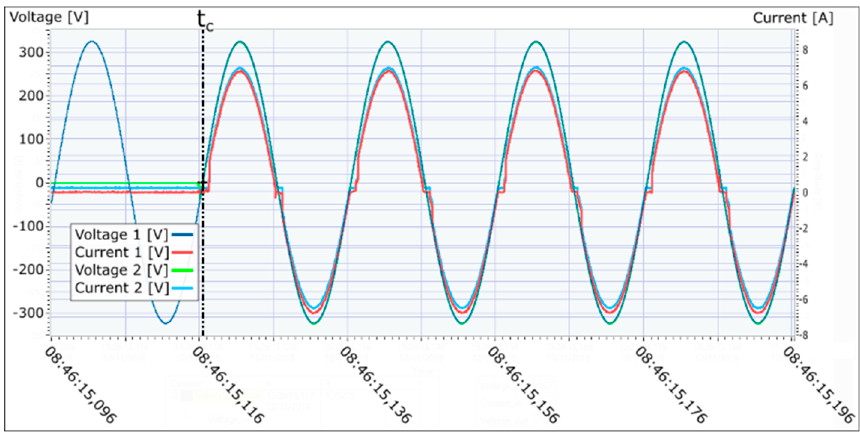
Figure 4. Instant ( t c ) at which the arc was formed (using the Bourns 2049-07 surge arrester).